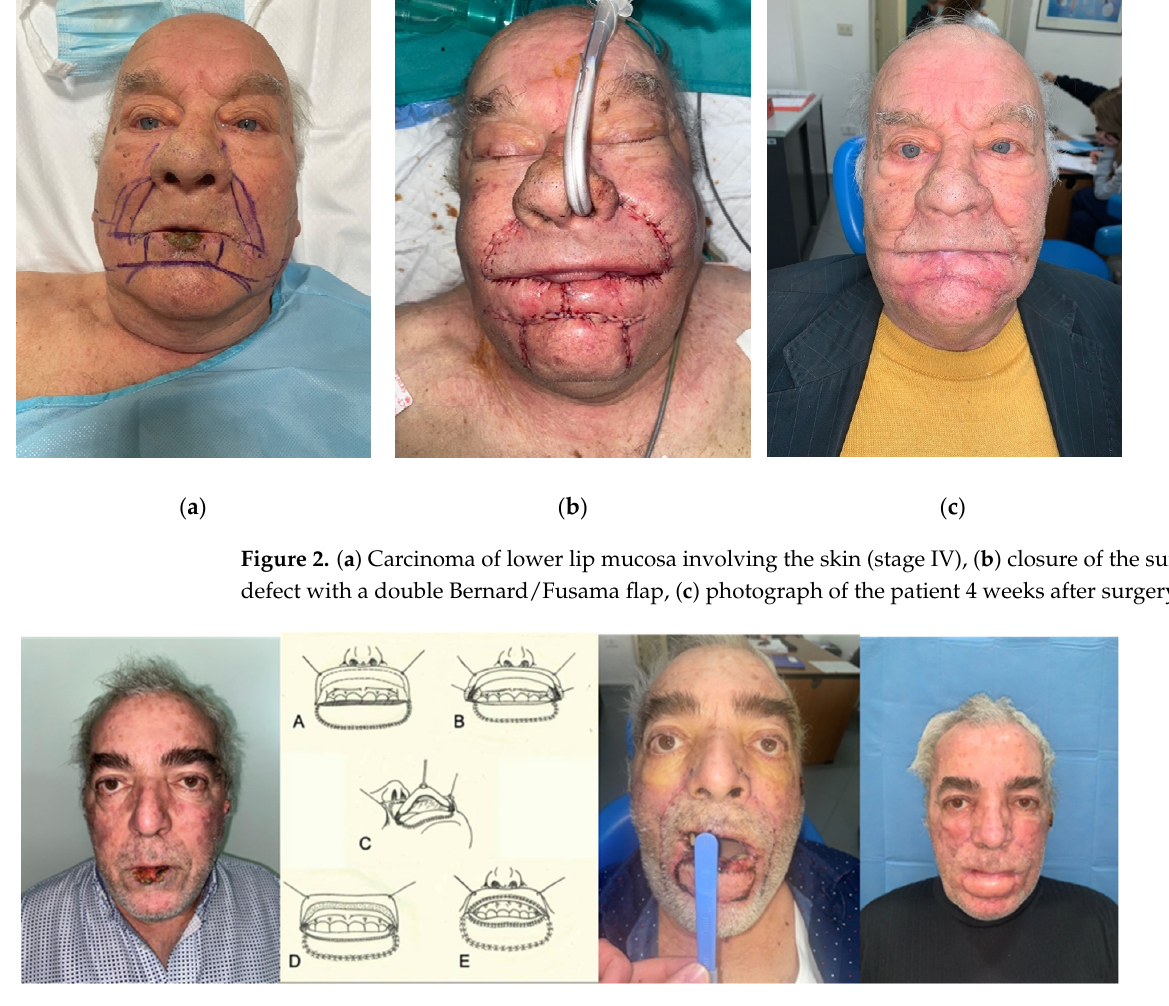
Figure 1. ( a ) Carcinoma of lower lip mucosa involving the skin (stage IV), ( b ) reconstruction of the surgical defect with radial free flap, ( c ) photograph of the patient 4 weeks after surgery.